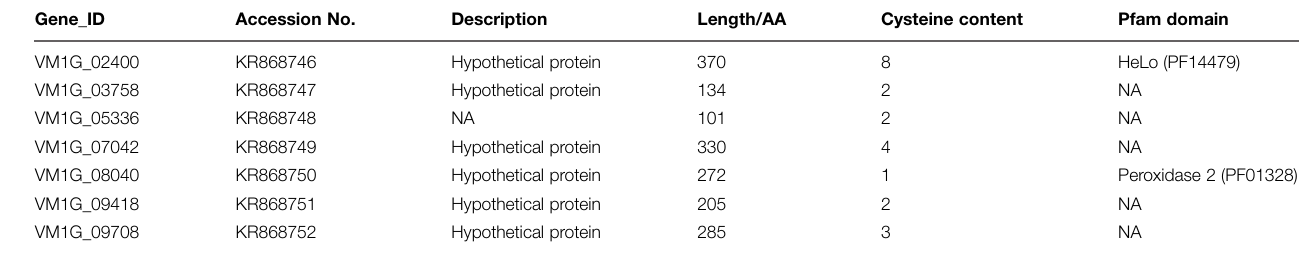
TABLE 1 | Sequence information of Valsa mali effector proteins